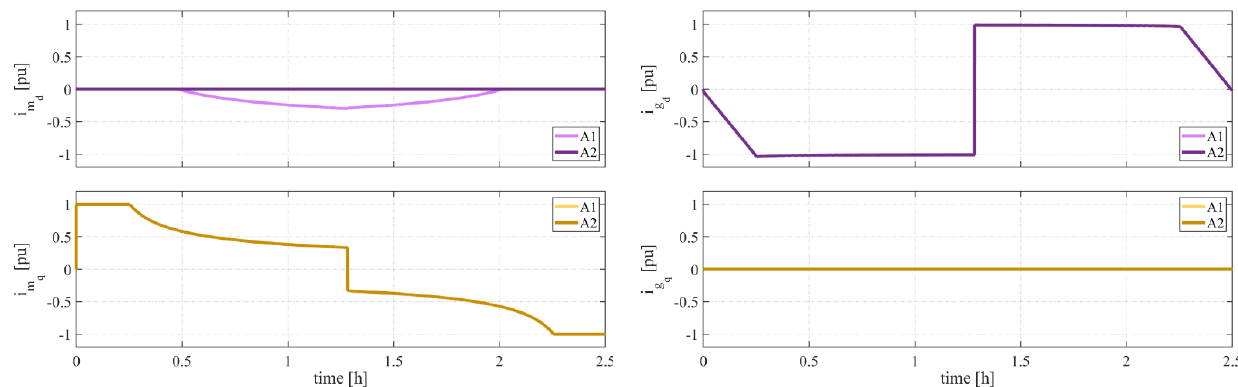
Figure 10. FESS torque ( T e ), speed ( ω m ), power ( P m ), DC-link voltage ( V DC ) and currents ( i g and i m ) achieved during round- trip tests (cases A1 and A2, quantities normalized to their corresponding rated values).